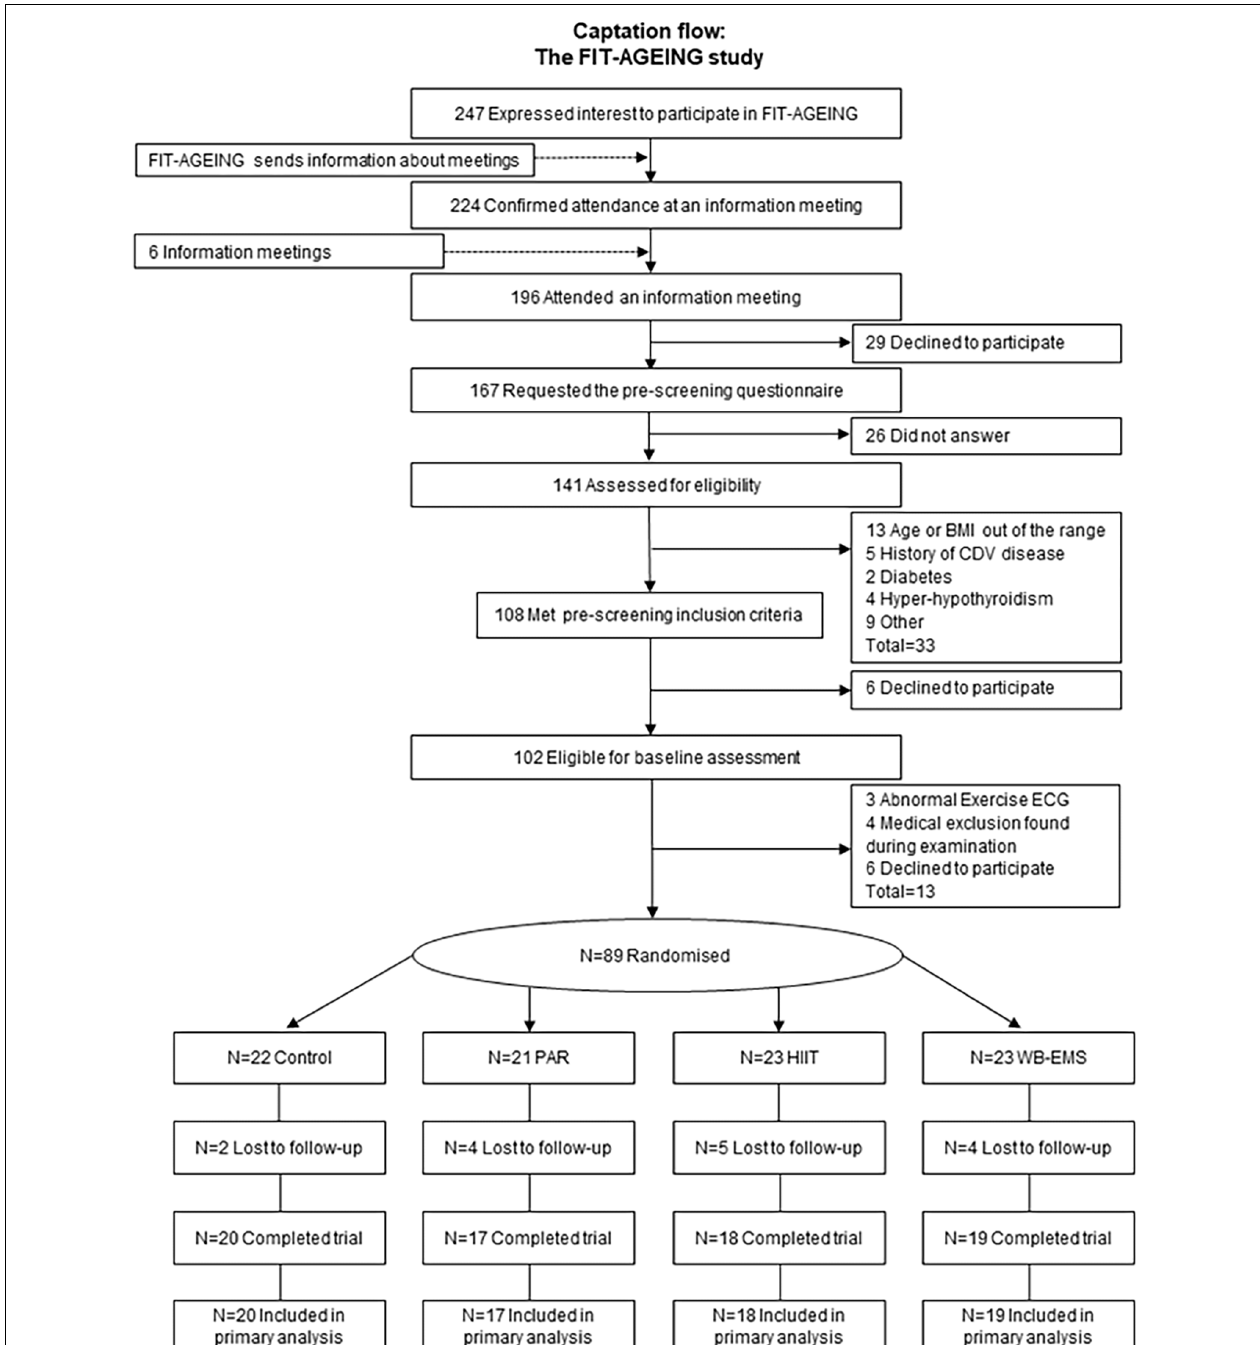
FIGURE 1 | Flow-chart diagram. BMI, body mass index; CDV, cardiovascular; ECG, electrocardiogram; PAR, physical activity recommendations for adults proposed by the World Health Organization group; HIIT, high intensity interval training group; WB-EMS, whole-body electromyostimulation